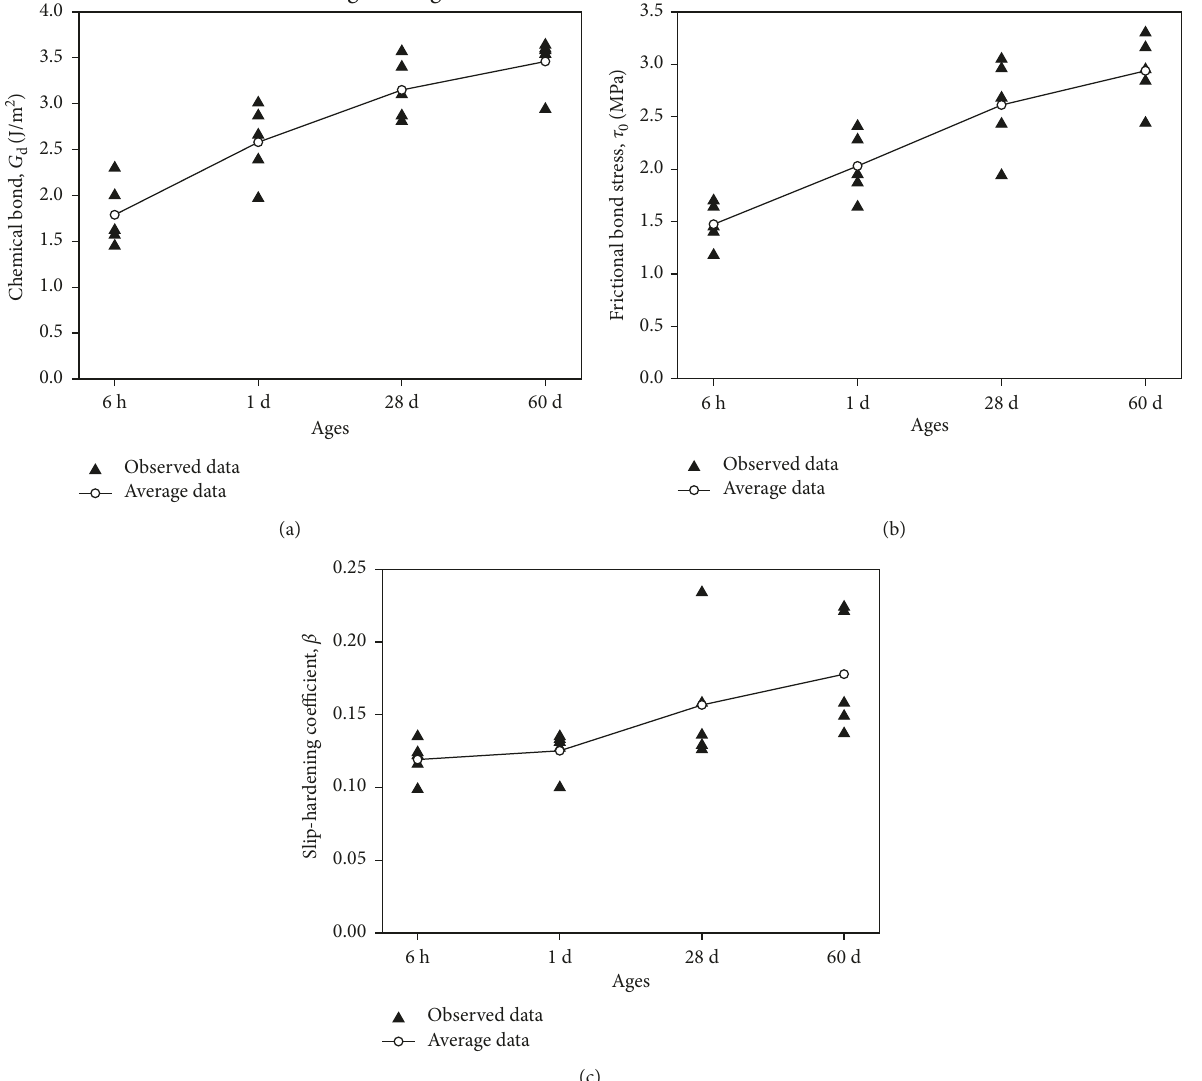
Figure 10: Influence of curing ages on REC-15 fiber/matrix interfacial parameters: (a) G